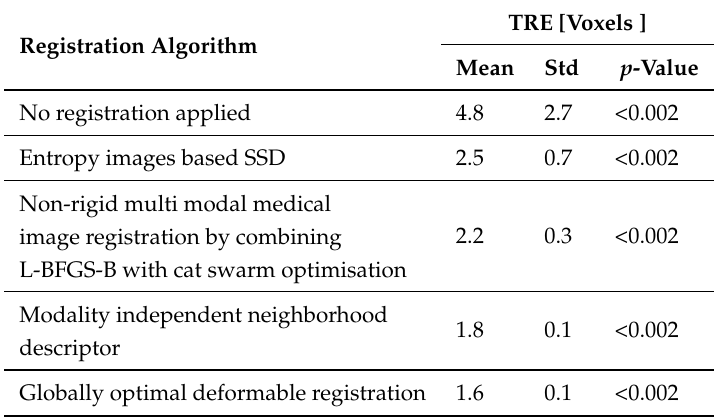
Table 11. The stats of several motion estimation procedures have been compared with the applied